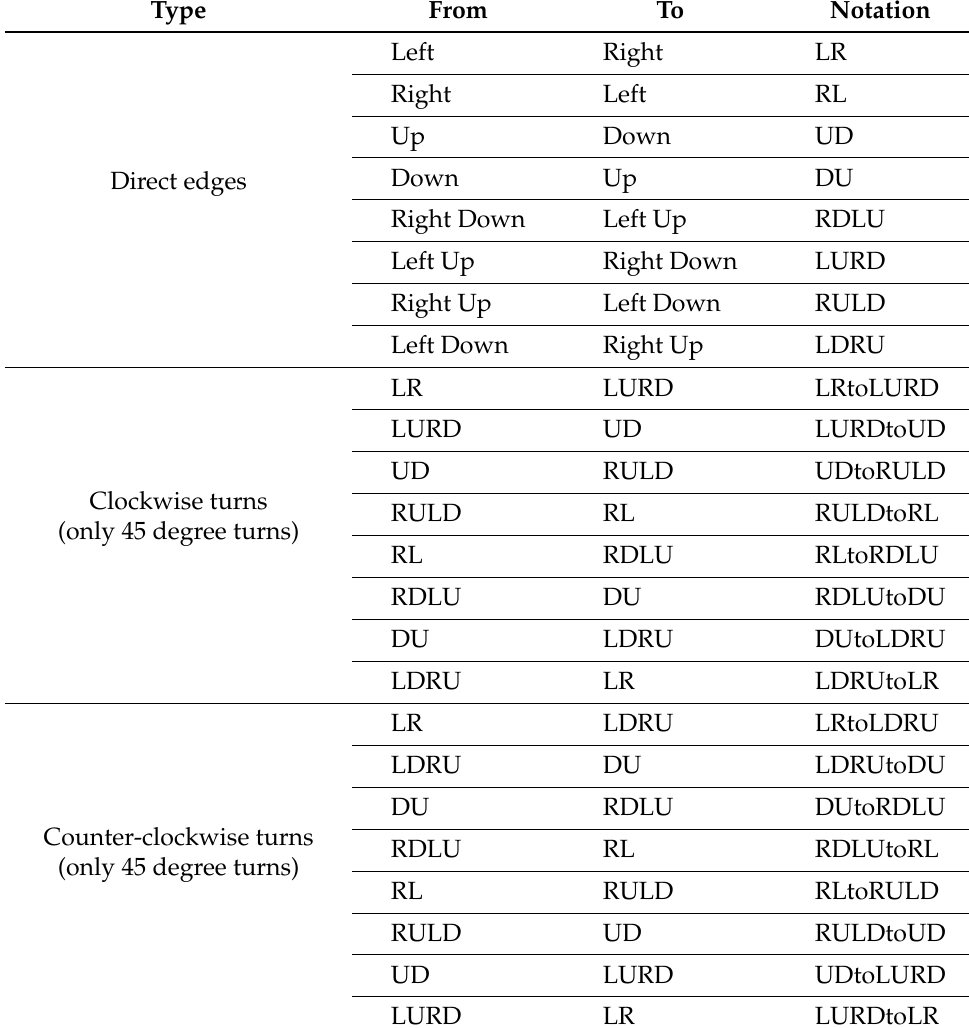
Table 1. Notations used in the MLTG method for direct moves and turns. Type From To Notation Left Right LR Right Left RL Up Down UD Down Up DU RULDDirect edges Right Down Left Up RDLU Left Up Right Down LURD Right Up Left Down Left Down Right Up LDRU LR LURD LRtoLURD LURD UD LURDtoUD UD RULD UDtoRULD Clockwise turns RULD RL RULDtoRL (only 45 degree turns) RL RDLU RLtoRDLU RDLU DU RDLUtoDU DU LDRU DUtoLDRU LDRU LR LDRUtoLR LR LDRU LRtoLDRU LDRU DU LDRUtoDU DU RDLU DUtoRDLU turns RDLU RL RDLUtoRL RL RULD RULD UD RULDtoUD UD LURD LURD